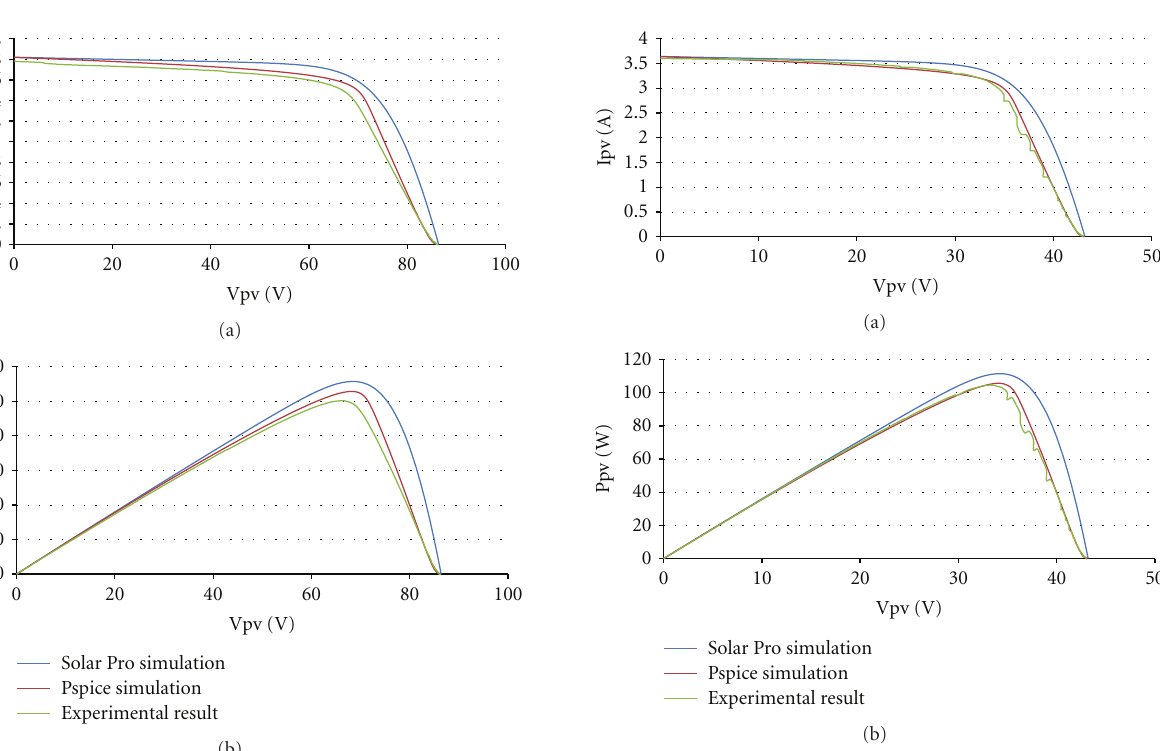
Figure 7: Comparison result for a 4 in series/1 in parallel module, (a) I - V , (b) P - V output characteristic curves.